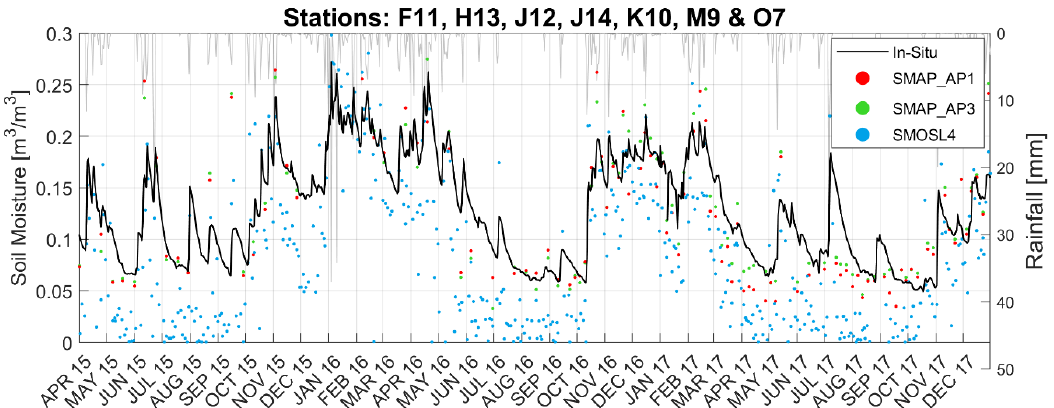
Figure 3. Daily evolution of in situ SSM (black) and the three high-resolution SSM products (SMAP_AP1 at 1 km, red; SMAP_AP3 at 3 km, green; and SMOSL4 at 1 km, blue) after averaging time series of rainfed/fallow stations (F11, H13, J12, J14, K10, M09, and O07) and the pixel time series that contain these stations. Table 4. Statistics obtained from the comparison of in situ SSM against the high-resolution pixel SSM of SMAP_AP1 at 1 km (left), SMAP_AP3 at 3 km (center) and SMOSL4 at 1 km (right) from April 2015 to December 2017 for the different seasons of the year and also for the entire study period (ESP). Statistics are obtained after averaging all-time series of rainfed/fallow stations (F11, H13, J12, J14, K10, M9 and O7) and the pixels that contain these stations.